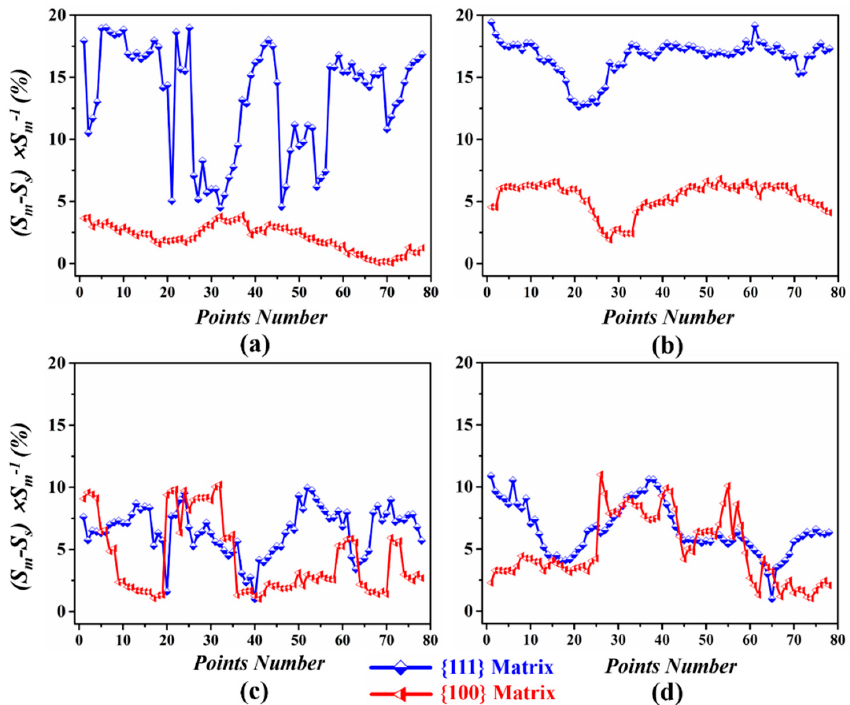
Figure 11. Schmid factor difference ratio (SFDR) values for 624 points selected in lines varying from ‘L1’ to ‘L8’. ( a ) For the points at the surface of the UR-Ta; ( b ) For the points at the center of the UR-Ta; ( c ) For the points at the surface of the CR-Ta; ( d ) For the points at the center of the CR-Ta.